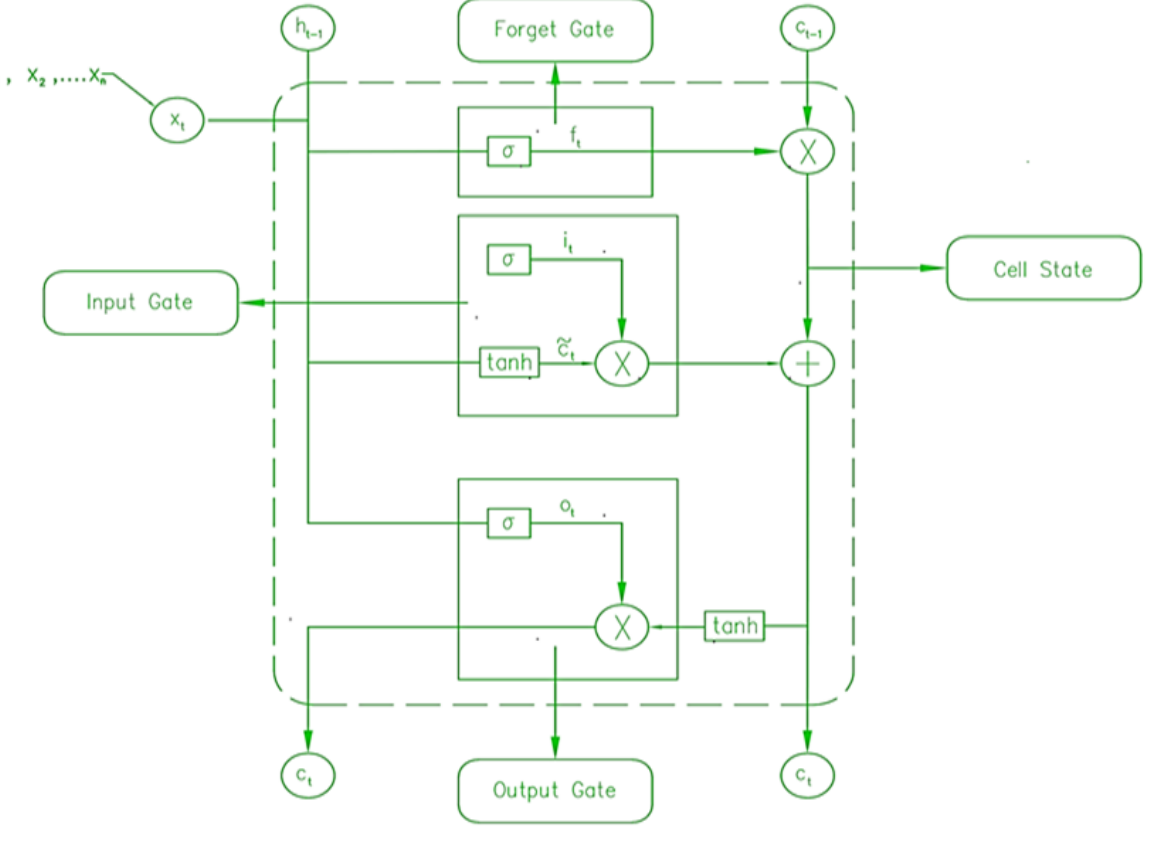
Figure 8. Basic architecture of Multivariate LSTM model.